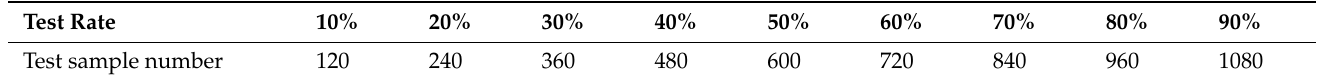
Table 6. The number of